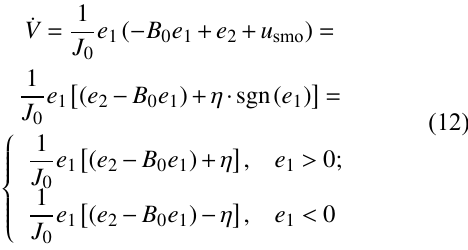
Fig. 2 Integrated observer